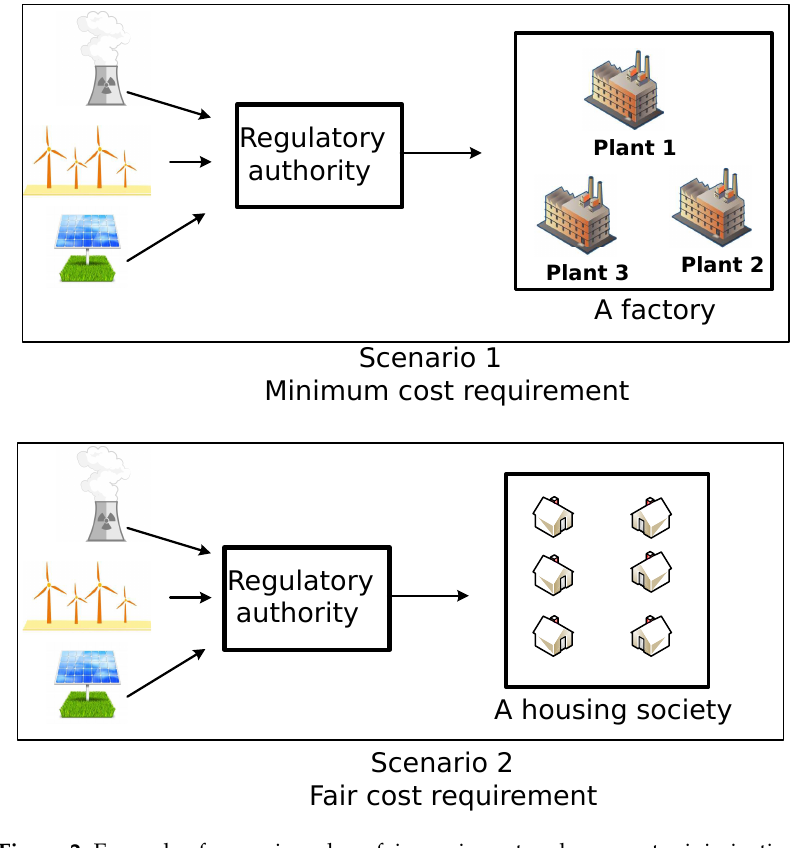
Figure 2. Example of scenarios where fairness in cost and sum cost minimization is required. Algorithm 2 Suboptimal scheme for fair cost